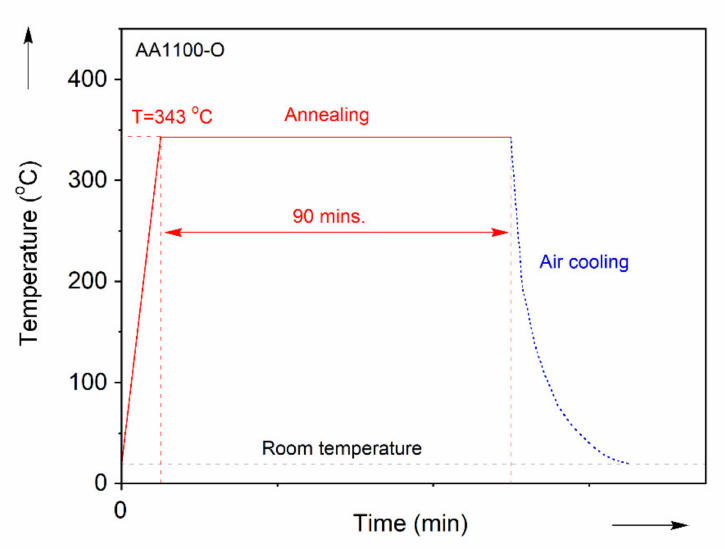
Figure 1. Heat-treatment profile of commercially-pure